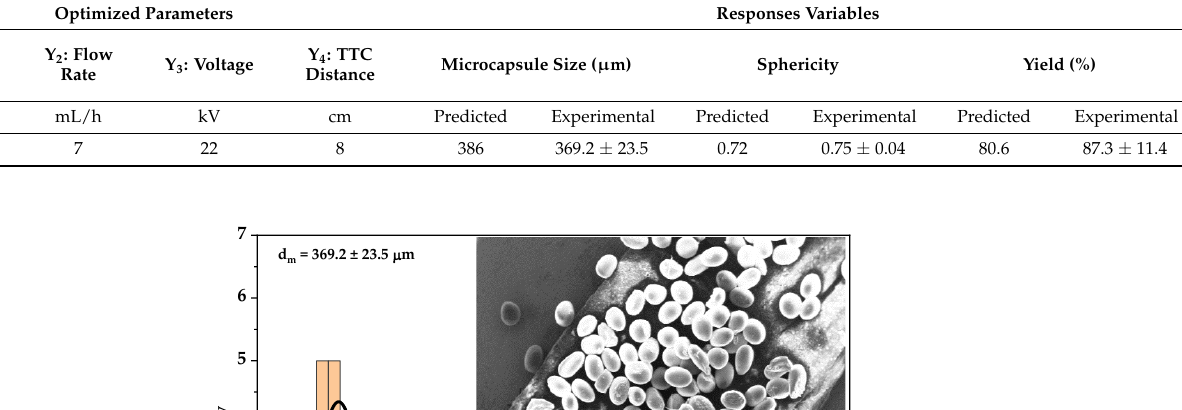
Table 7. The predicted and experimental response at the optimized conditions of the process.